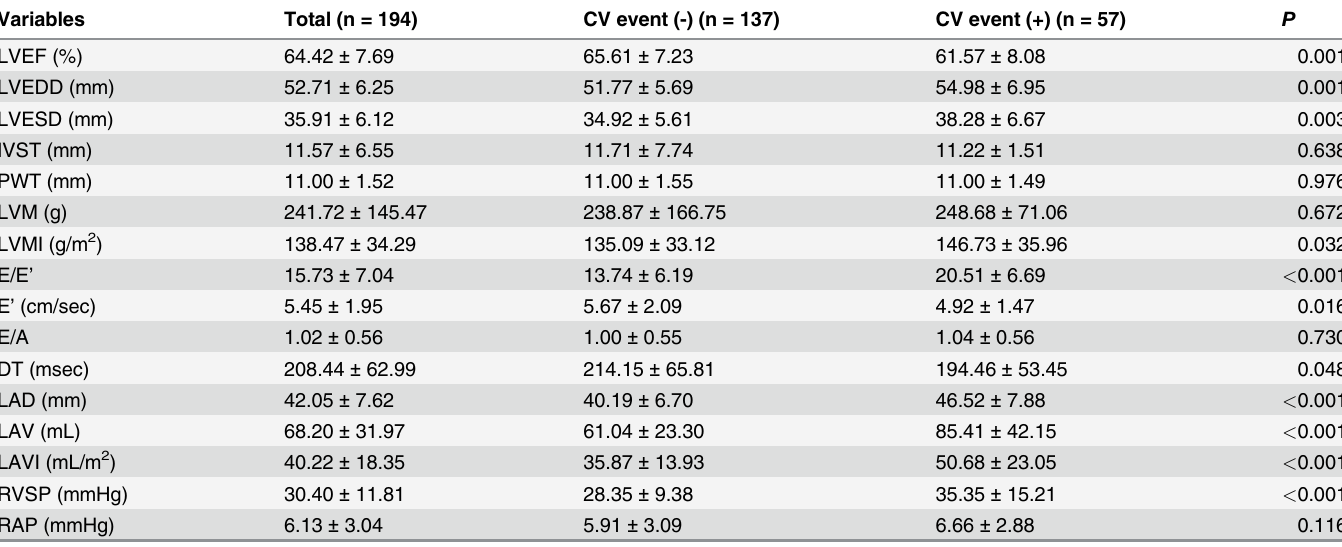
such as age, history of DM, CAD, cerebrovascular disease, arrhythmia, serum albumin and NT-proBNP levels, and 24-hour urine volume were significantly associated with CV events. Table 3. Baseline echocardiographic parameters of the study patients according to the presence of CV